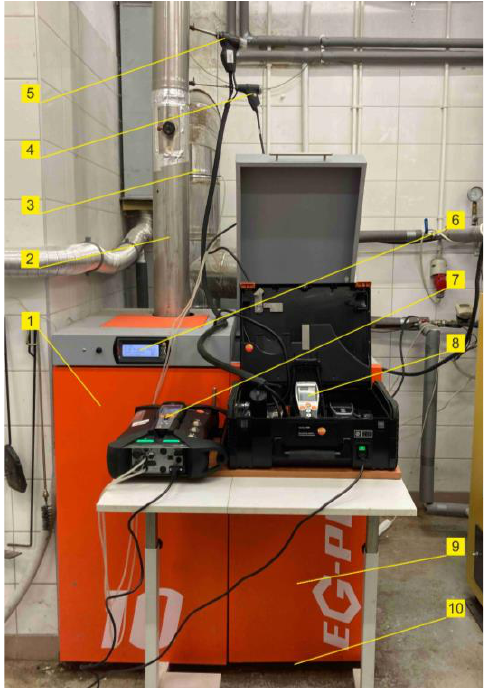
Figure 2. Boiler test stand: 1—test boiler, 2—chimney, 3—Pitot tube, 4—fume probe, 5—flow probe, 6—boiler controller, 7—Testo 350—flow meter, 8—Testo 380—PM meter, 9—pellet reservoir,